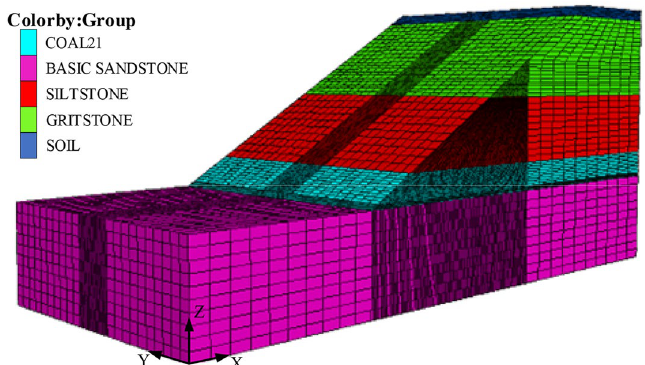
Figure 9. Numerical model of the slope.